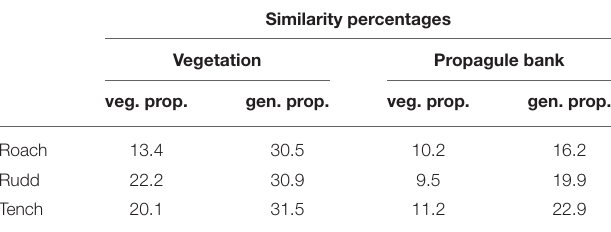
Vegetative dispersal is also likely for filamentous algae. TABLE 3 | Similarity percentages for egested vegetative and generative propagules and the species pool of the vegetation and propagule bank,